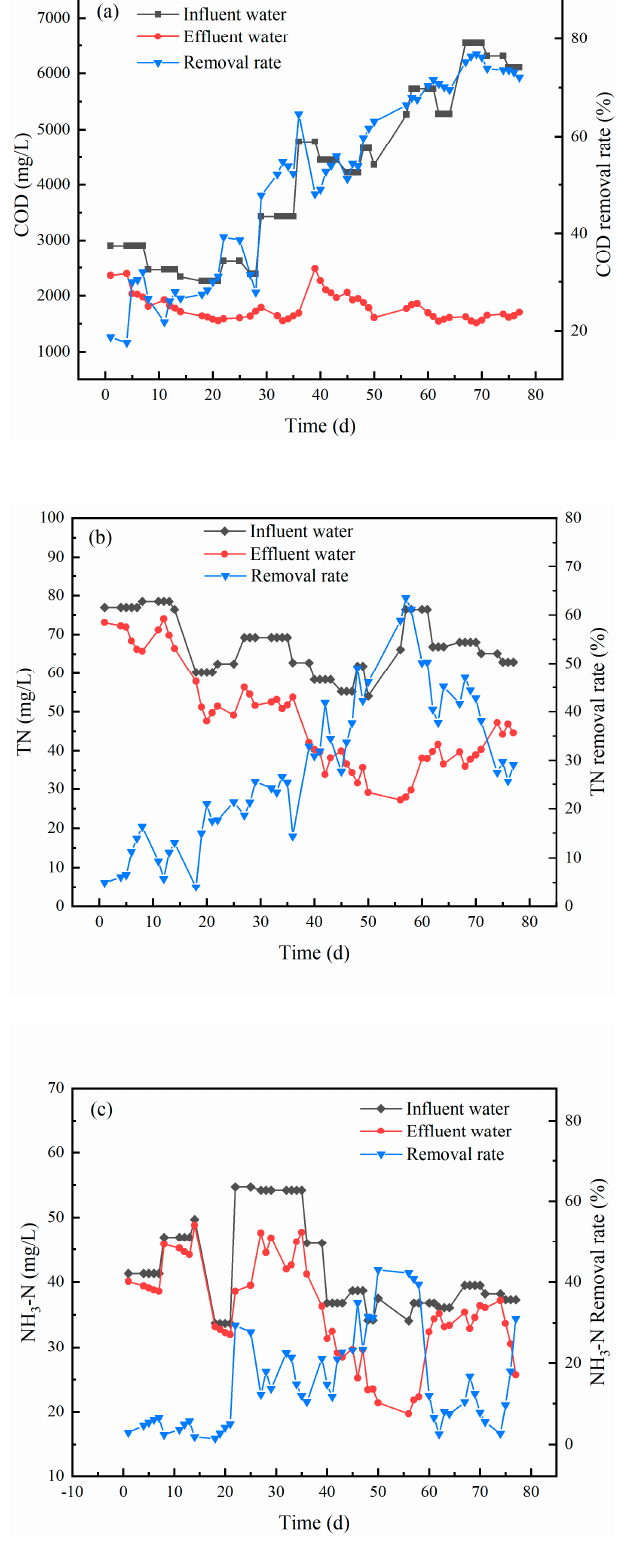
Figure 3. Effect of running time on treatment efficiency of the hydrolysis acidizing unit: ( a ) COD, ( b ) TN, and ( c ) NH 3 -N.